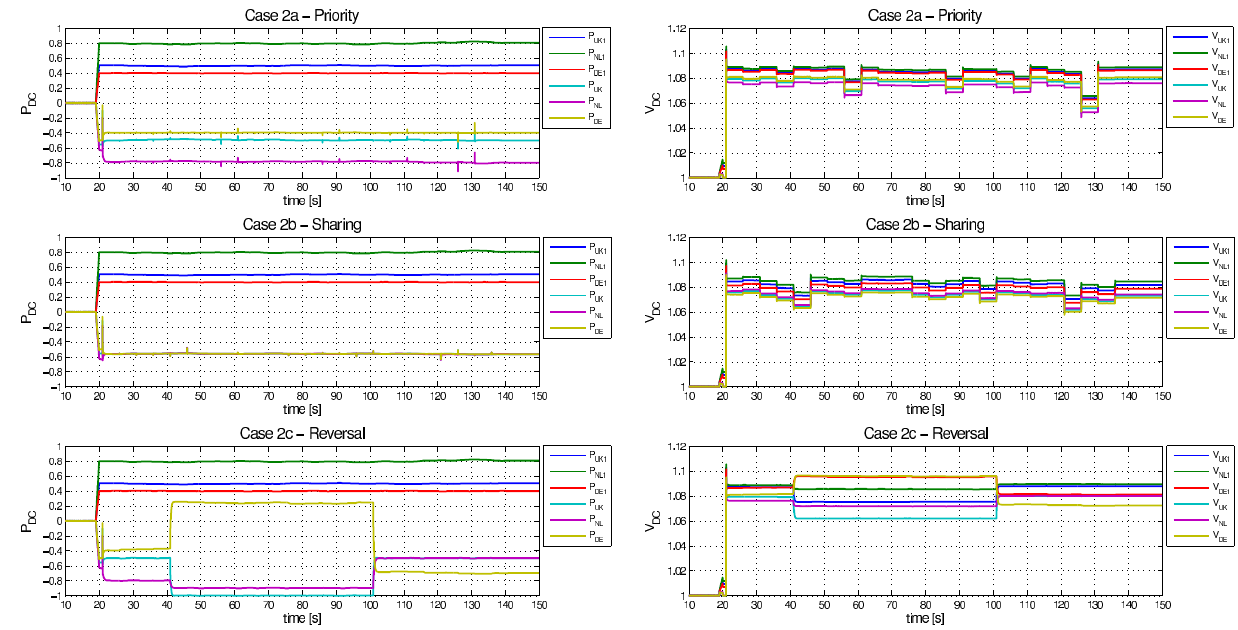
Figure 12. Results from Case Study 2: Normal